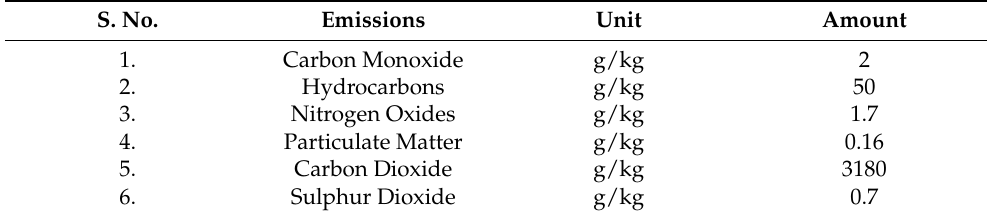
Table 4. Total emissions generated for 1 L of fuel for trucks.